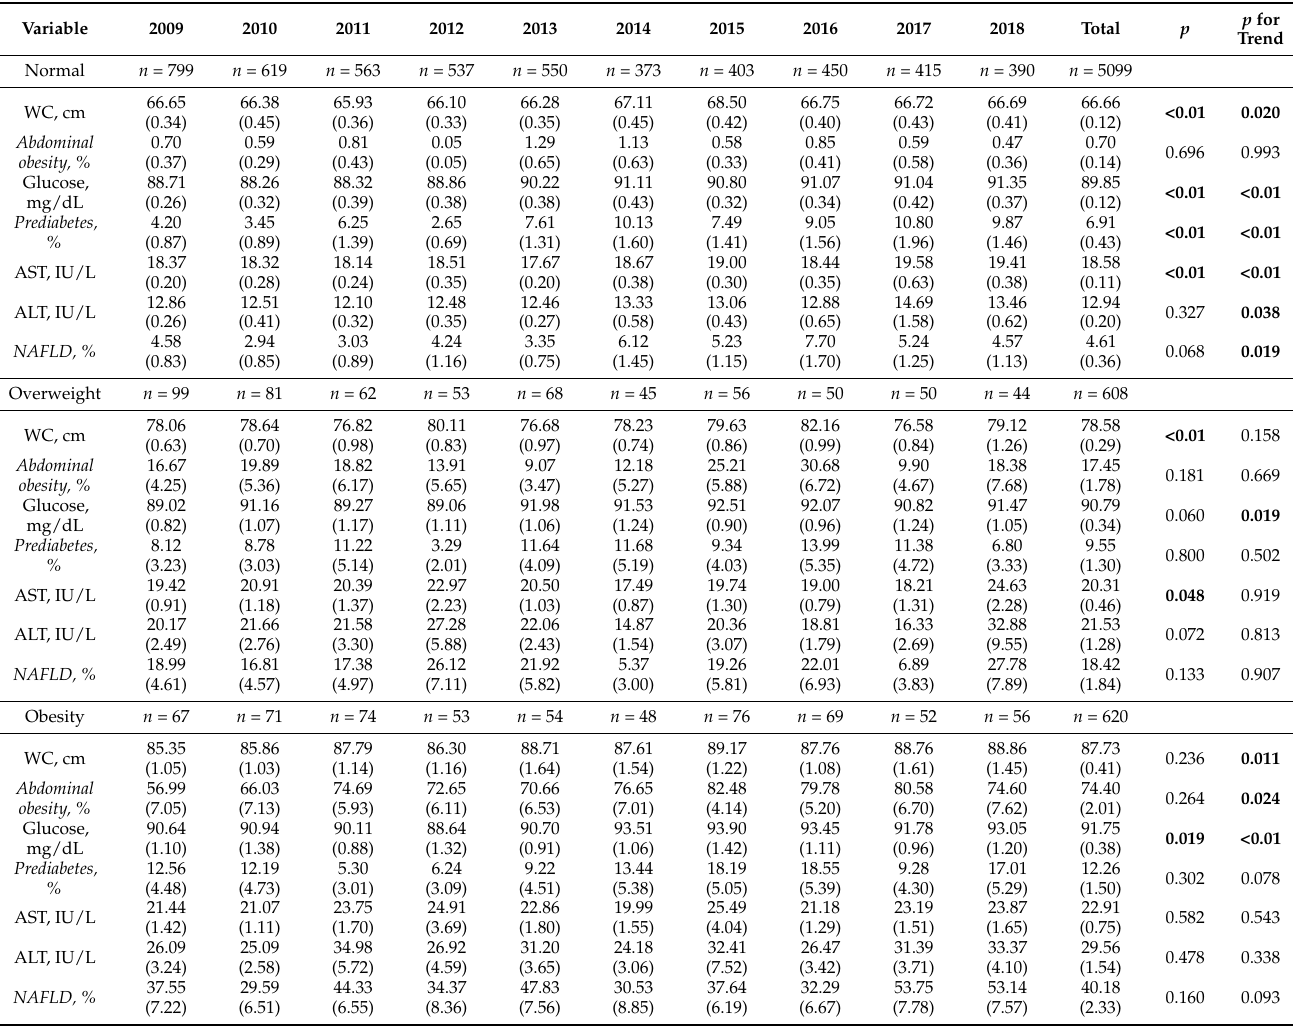
Table 3. Trends of prediabetes of the participants according to BMI classification.